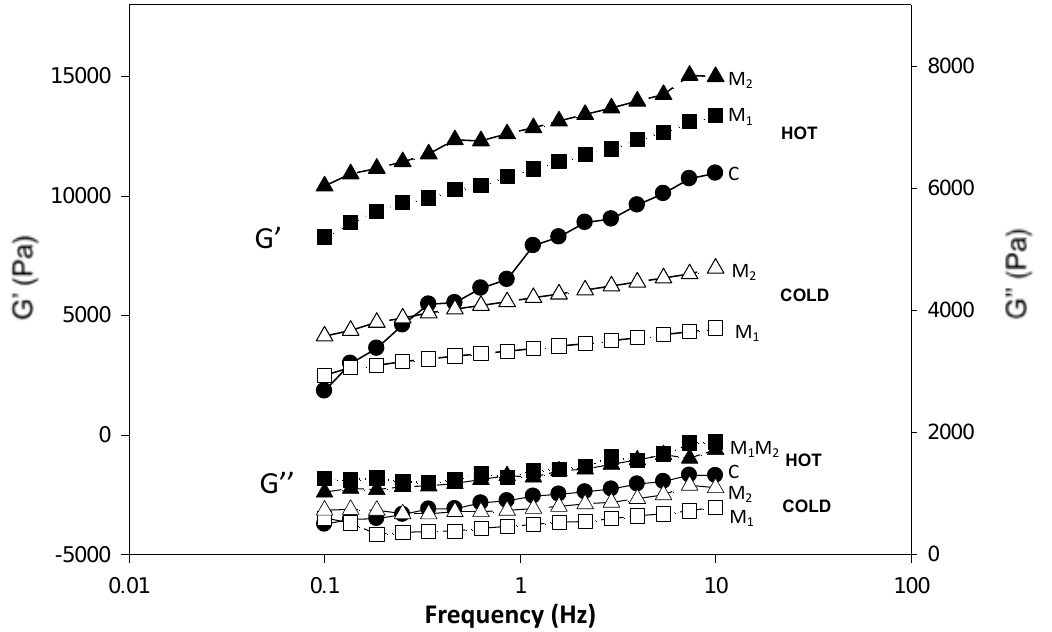
Figure 4. Frequency sweep curves of the systems formed with the three flours (circle: C, square: M 1 and triangle: M 2 ) at the 75% moisture content in the cold condition (white) and hot condition (black).